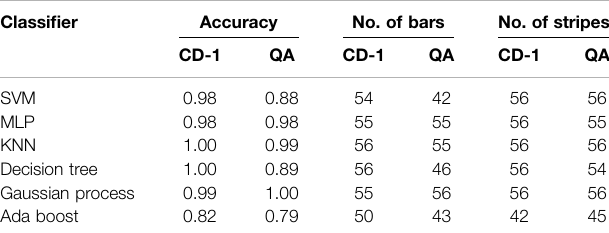
TABLE 1 | Comparison of classi fi ers trained on compressed BAS dataset obtained from CD-1 and QA trained RBMs. The classi fi cation accuracy was estimated on the test data comprised of 56 bars and 56 stripes instances. The label “ No. of bars ” (No. of stripes) indicates the number of correctly predicted bar (stripe) instances. The labels CD-1 and QA indicate that the feature reduction was performed using contrastive divergence and quantum annealing,